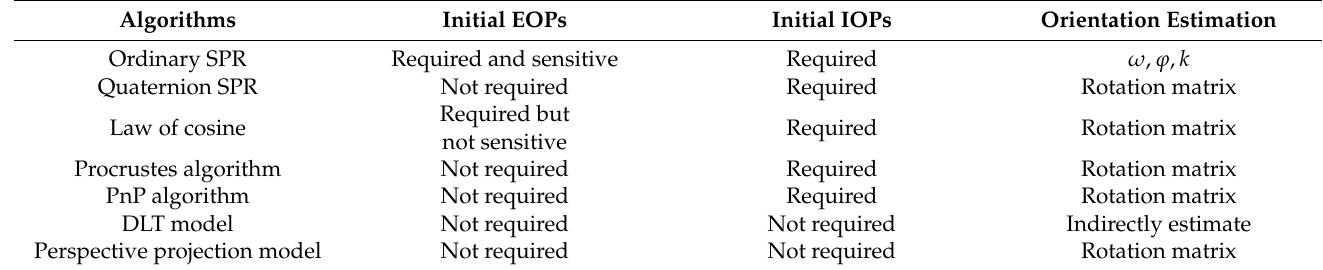
Table 1. Characteristics of each camera position and orientation estimation